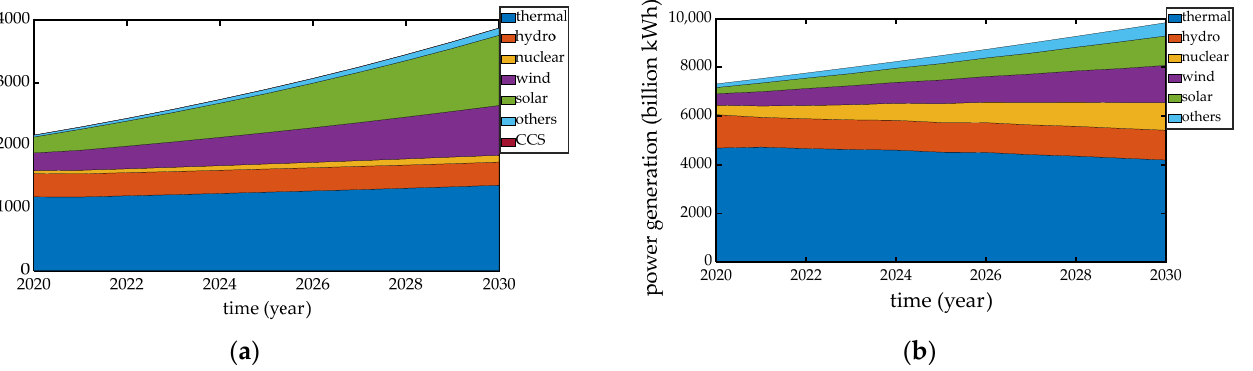
Figure 6. The model solution results. ( a ) Optimal path of installed capacity; ( b ) Optimal path of annual power generation.